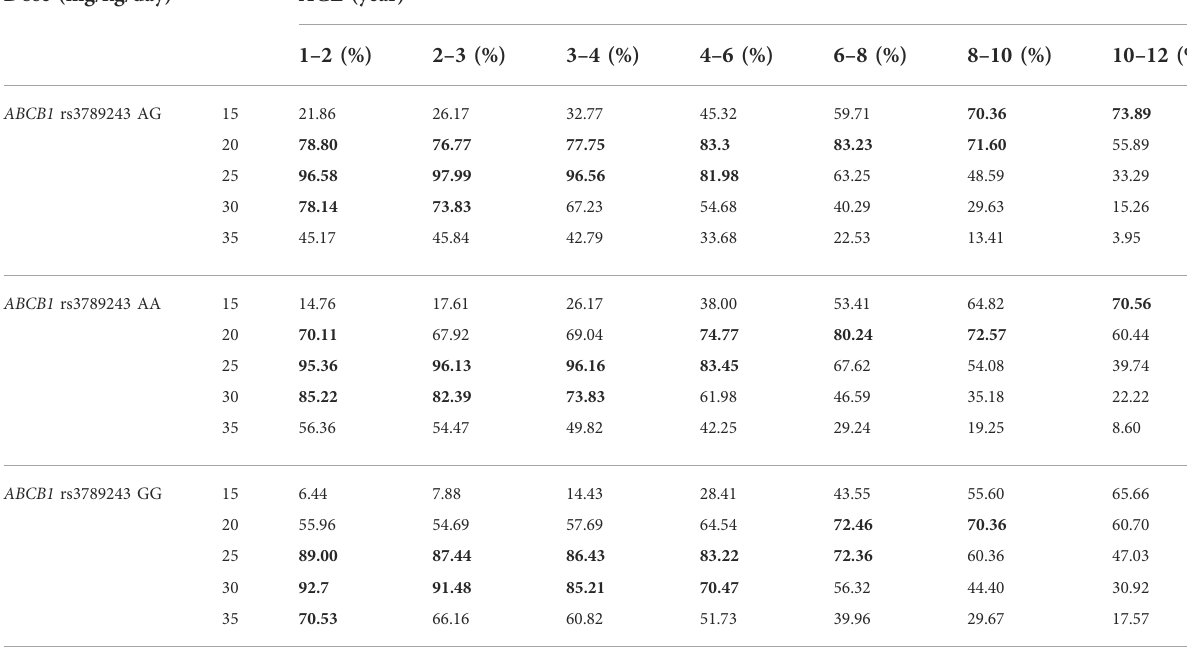
TABLE 5 Probability of target attainment for various predicted valproic acid daily dose using the fi nal model. Dose (mg/kg/day)